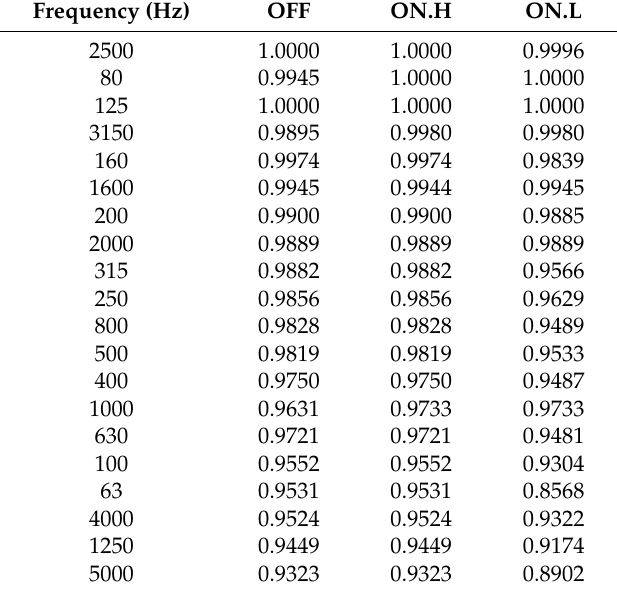
Table 3. Variable importance .